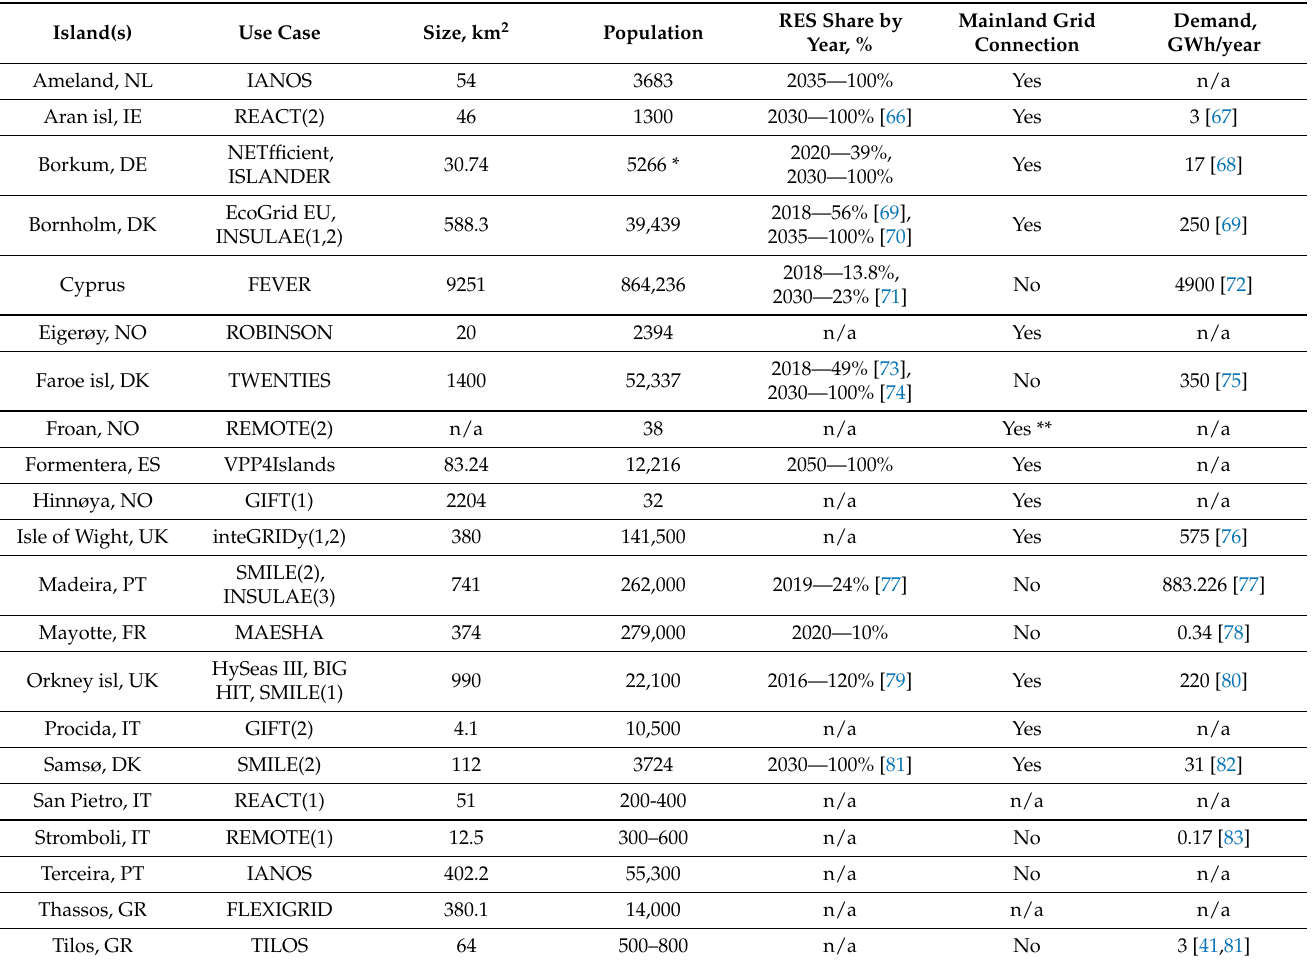
Table 2. Characterization of EU islands hosting MES